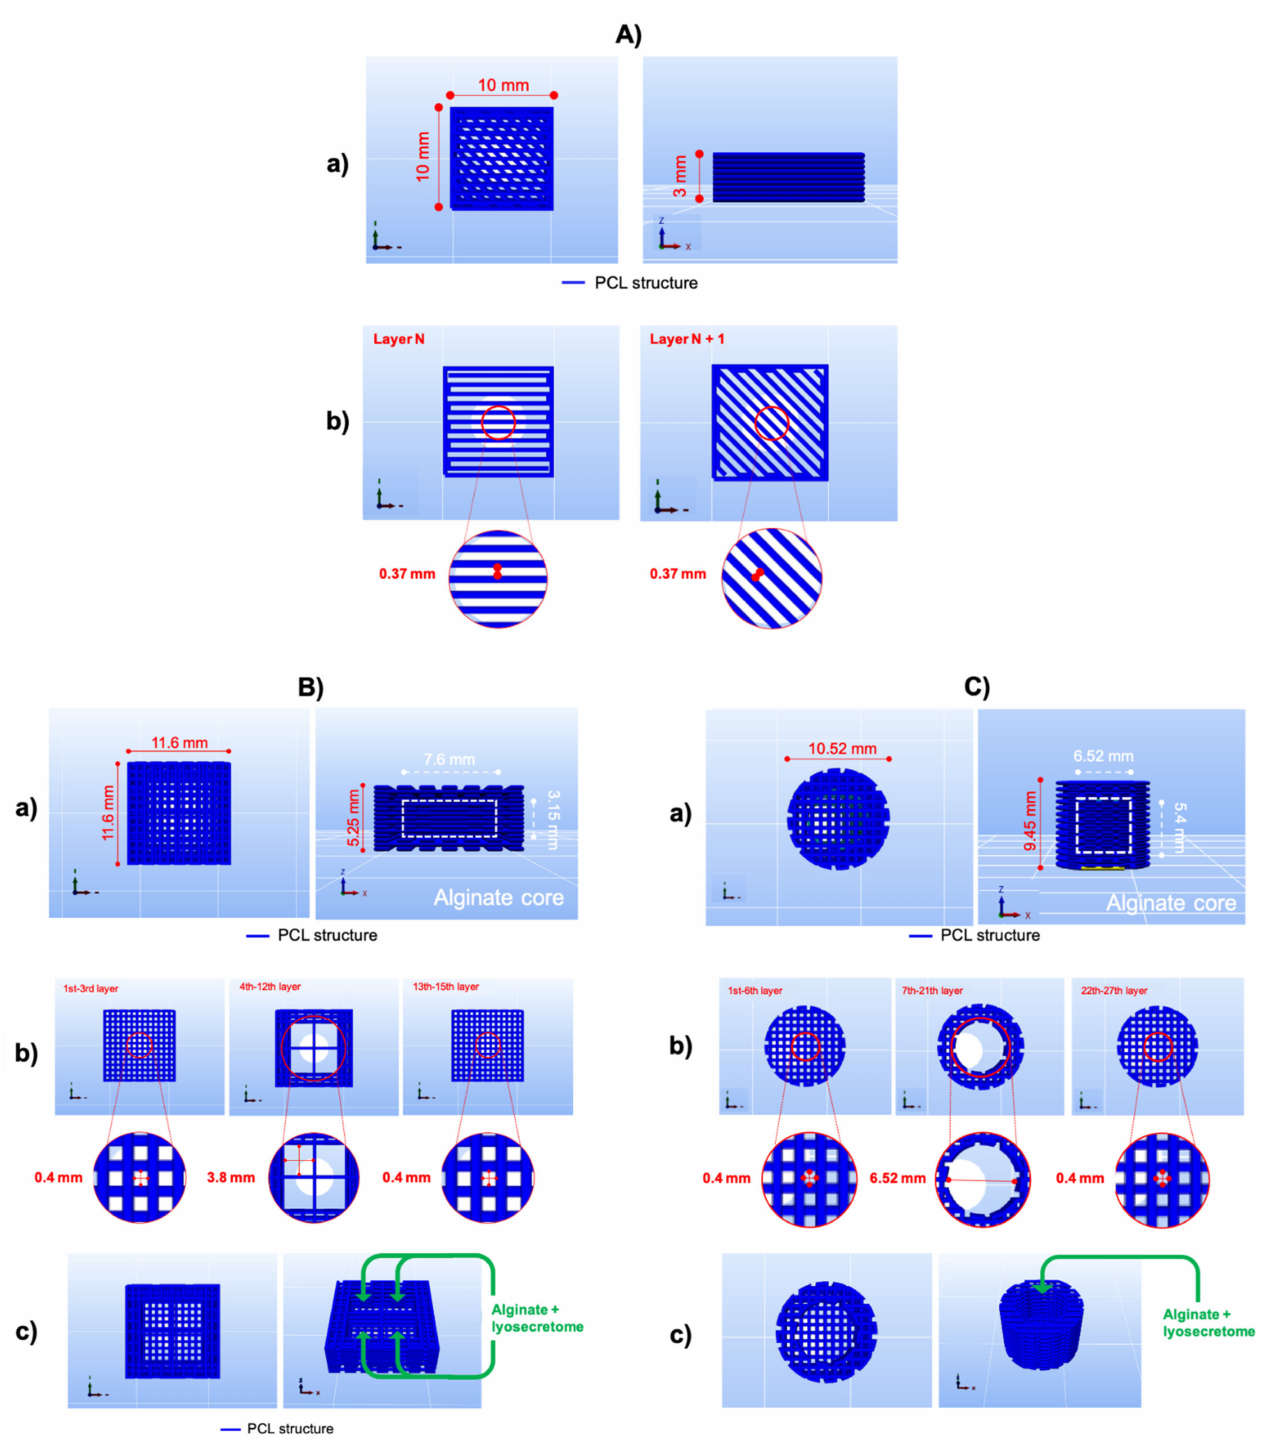
Figure 2. Scaffold geometry and dimensions for the two different strategies investigated. ( A ) PCL scaffold 3D-printed and subsequentially loaded with lyosecretome; planar and sectional view of the total scaffold ( a ) and planar view of the scaffold layers ( b ). ( B ) Coprinting parallelepiped- and ( C ) cylindrical-shaped scaffolds with a “soft heart” of lyosecretome-laden alginate (i.e., bioink). Planar and sectional views of the total scaffold ( a ), planar view of the scaffold layers ( b ), and well into bioink was extruded ( c